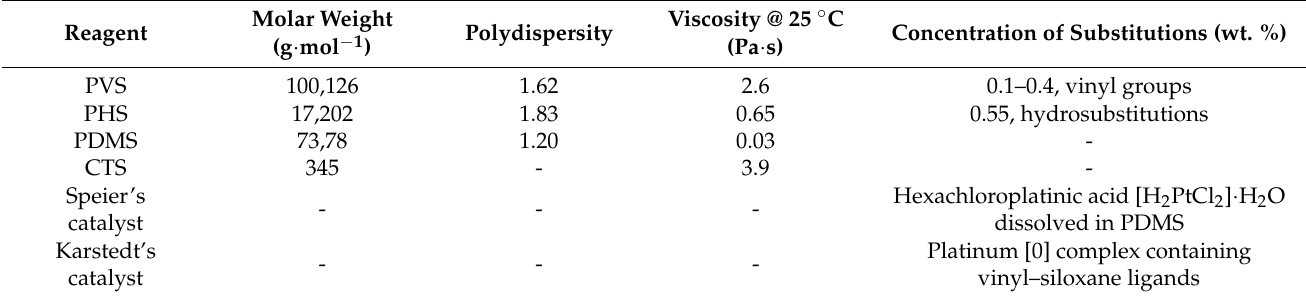
Table 2. Polymer phase: Characteristics of raw polymer for Nanoembosile ® preparation.